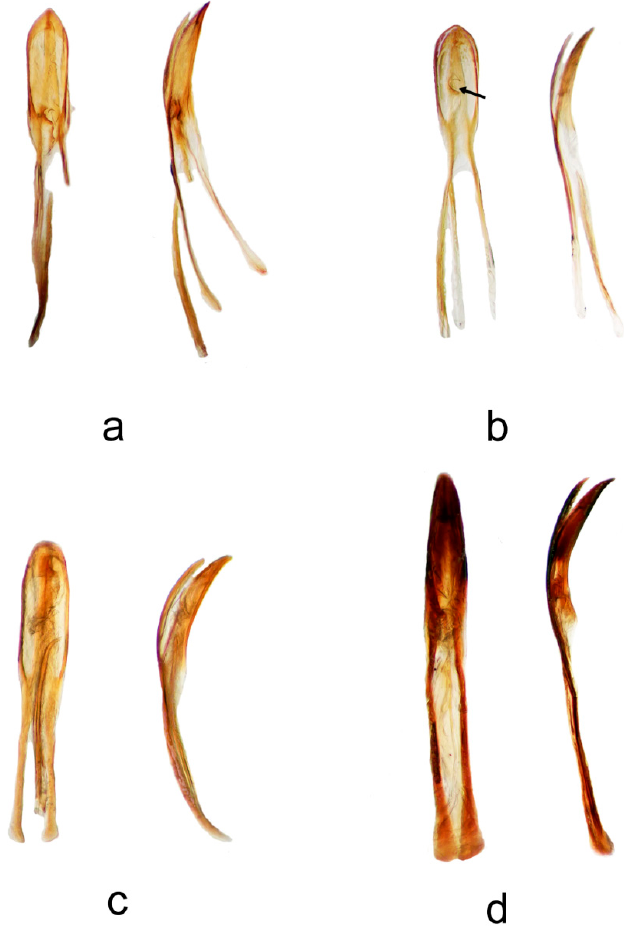
Figure 5. Penis in ventrodorsal (left) and lateral (right) view of ( a ) Afroryzophilus djibai ; ( b ) A. centrafricanus ; ( c ) A. kuscheli ; ( d ) A. congoanus. Black arrow indicates a sclerite inside the endophallus. (Not at the same scale).